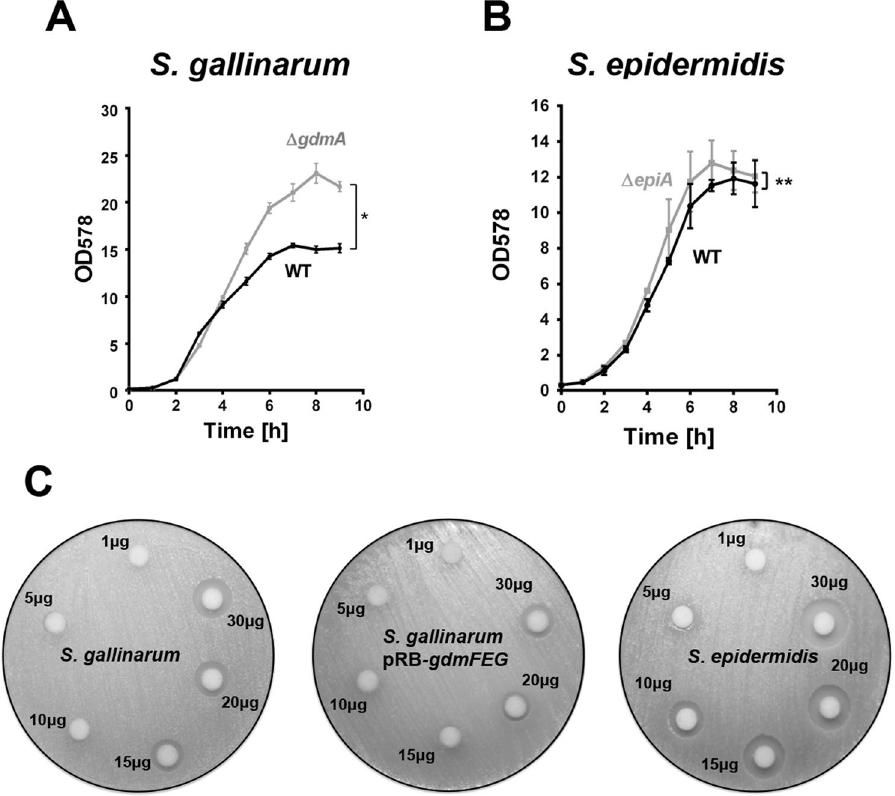
Figure 1. Growth of wild type strains with their lantibiotic-deficient mutants and Gdm-susceptibility comparison of the S. gallinarum and S. epidermidis . ( A ) S. gallinarum and its gdmA deletion mutant. ( B ) S. epidermidis and its epiA deletion mutant. Representative data from two independent experiments are shown. For all graphs, each data point represents the mean value ± SD * p < 0.05, ** p < 0.01 by unpaired t-test comparing the parent strain with its corresponding epiA/gdmA mutants. ( C ) Agar-diffusion test with S. gallinarum (left), S. gallinarum pRB- gdmFEG (middle) and S. epidermidis (right) as reporter strain using increasing concentrations (1, 5, 10, 15, 20, 30 μ g) of